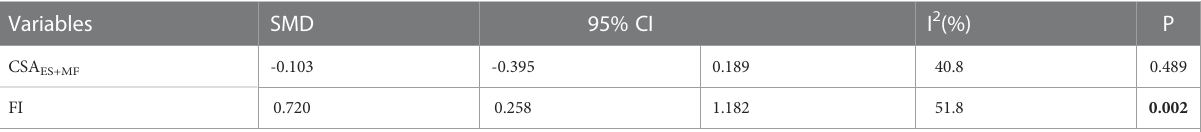
TABLE 3 The pooled analysis of paraspinal muscle characteristics in patients with and without recurrent OVF.